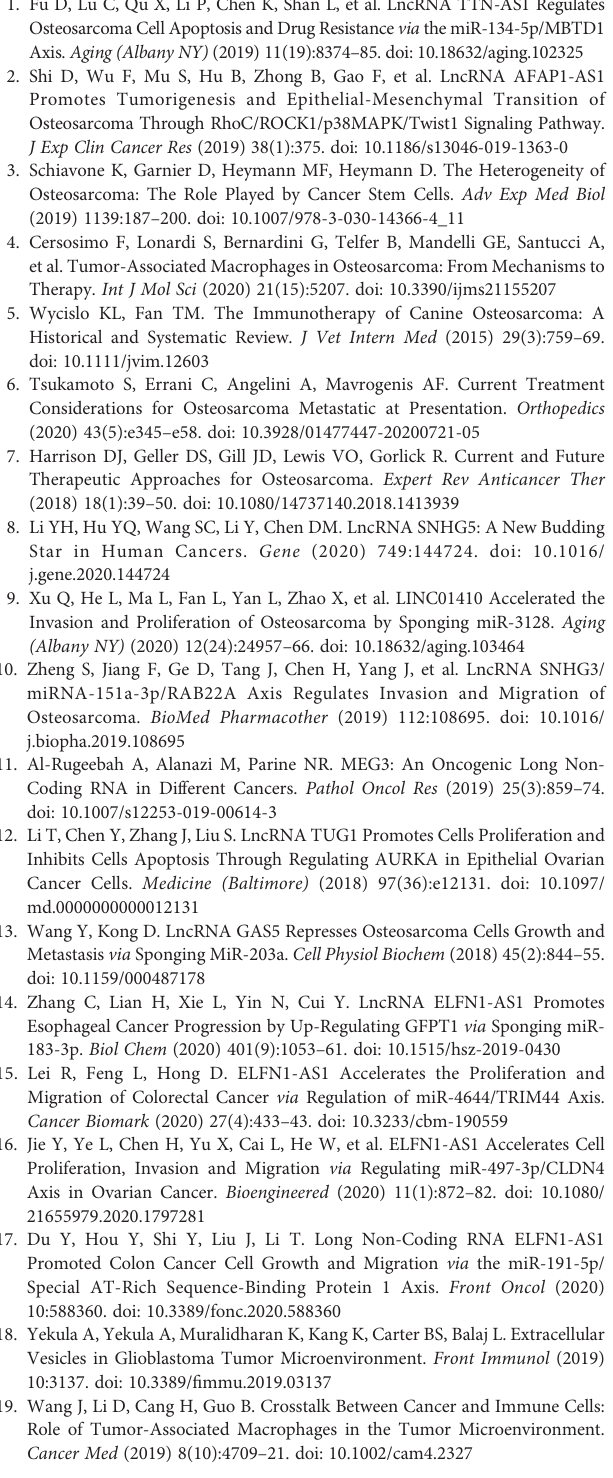
Supplementary Figure 3 | CREB1 siRNA reduced the expression of CREB1 in macrophages.